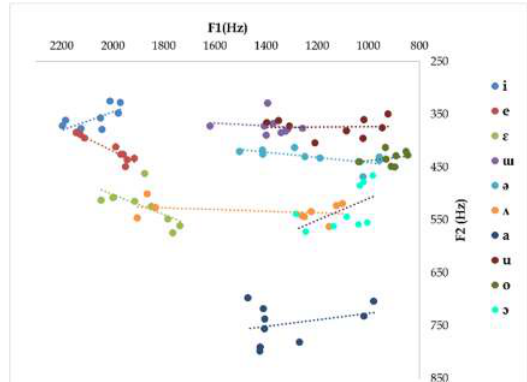
Figure 9 . Scatter plot of back vowel formant